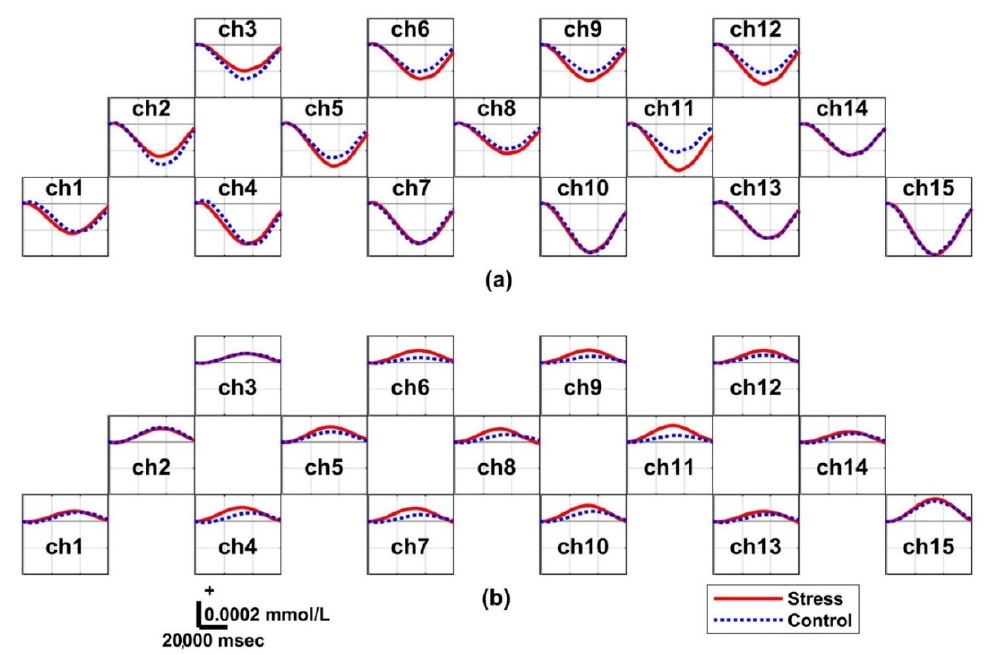
Figure 5. Grand averaged temporal hemodynamic oscillation changes within the interval of each epoch in Session 2 for the control and stress groups: ( a ) oxygenated hemoglobin ( ∆ HbO) and ( b ) reduced hemoglobin ( ∆ HbR). The red and blue dotted lines correspond to the stress and control group, respectively. The stress group shows slightly higher brain activation than the control group on average under Session 2 of finding negative stimulation conditions.